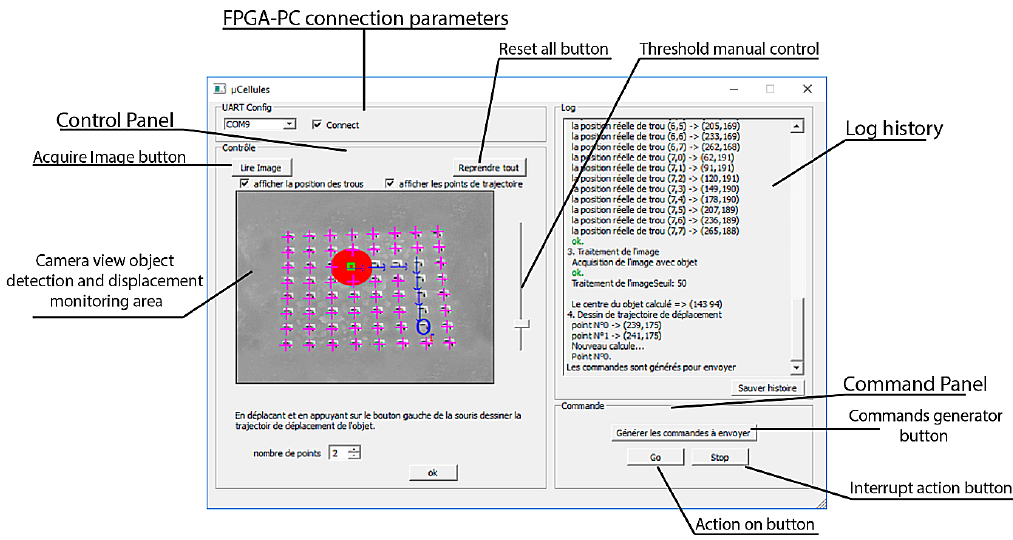
Figure 9. The IPDC Graphical User Interface (GUI) for monitoring and command.